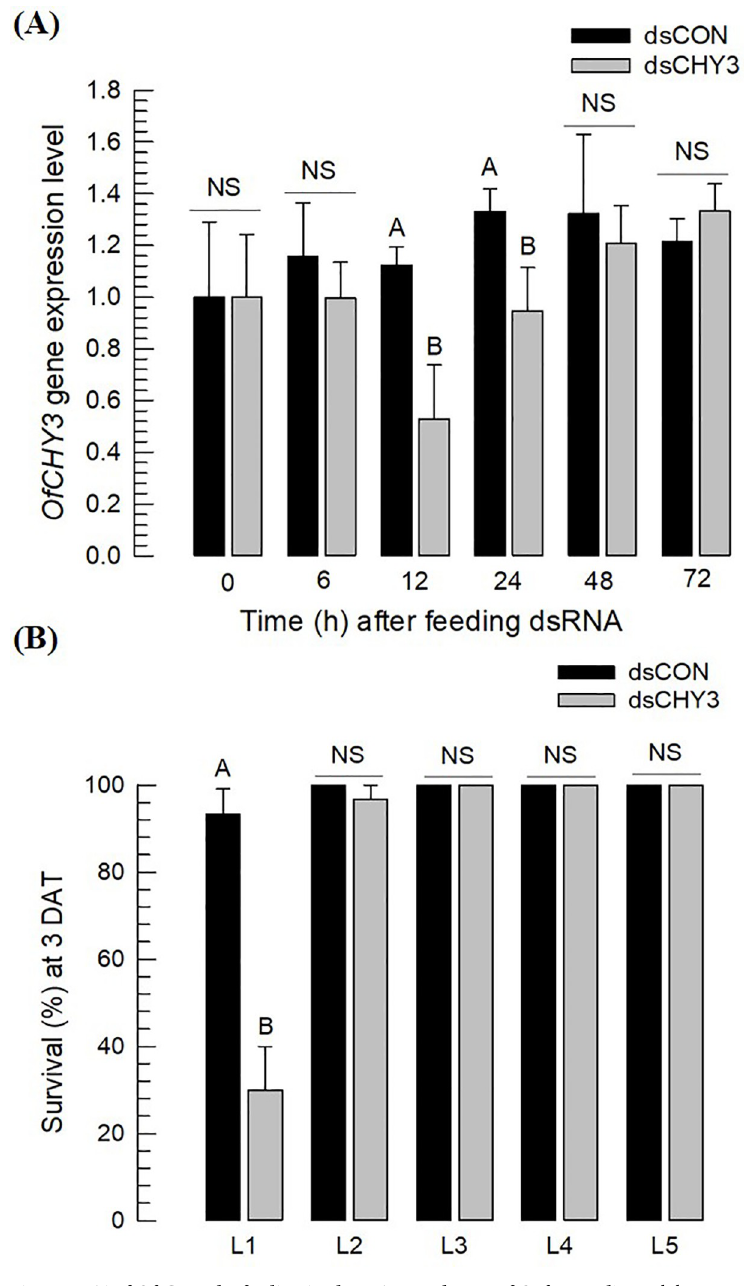
Fig 7. RNAi of Of-CHY3 by feeding its dsRNA to L3 larvae of O . furnacalis . Each larva was fed 10 μ g of dsRNA. As control, the same amount of dsRNA (‘dsCON’) specific to EGFP was fed. (A) Changes in expression levels of OfCHY3 after oral administration of dsRNA injection to L3 larvae. RT-qPCR used RNA samples collected from whole body. (B) Effects of feeding dsRNA on survival of O . furnacalis larvae at different stages. Survival rate was determined at three days after treatment (‘3 DAT’). Each treatment was replicated three times. Ten larvae were used in each replication. Different letters above standard error bars indicate significant difference among means at Type I error = 0.05 (Tukey